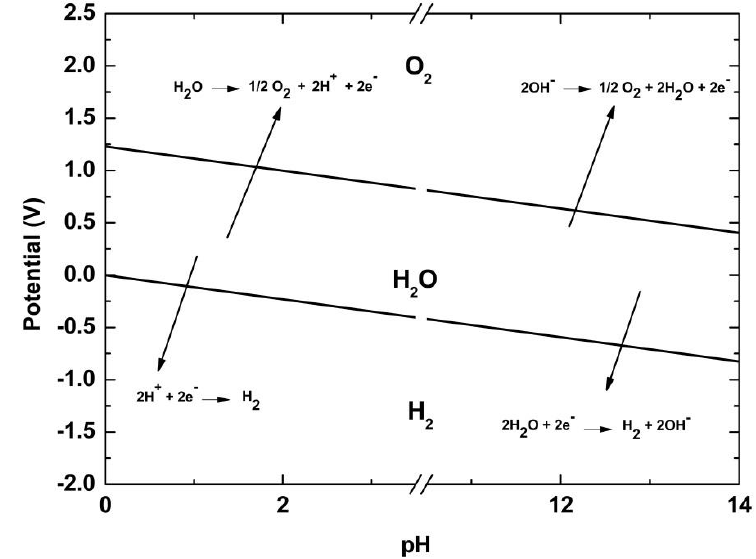
Figure 2. Hydrogen evolution reaction (HER) and oxygen evolution reaction (OER) in acidic and basic electrolyte, respectively.